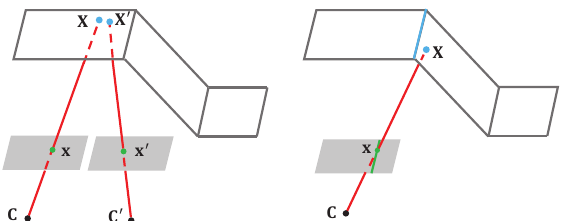
Figure 3: Examples of back-projection processes of the image corresponding feature points (Left) and the structure line (Right). The first optimization goal is to minimize the differences between the corresponding points X and X ′ for the former and the second one is to minimize the distances between the blue 3D structure line and the points like x located in the green 2D structure line in the image for the